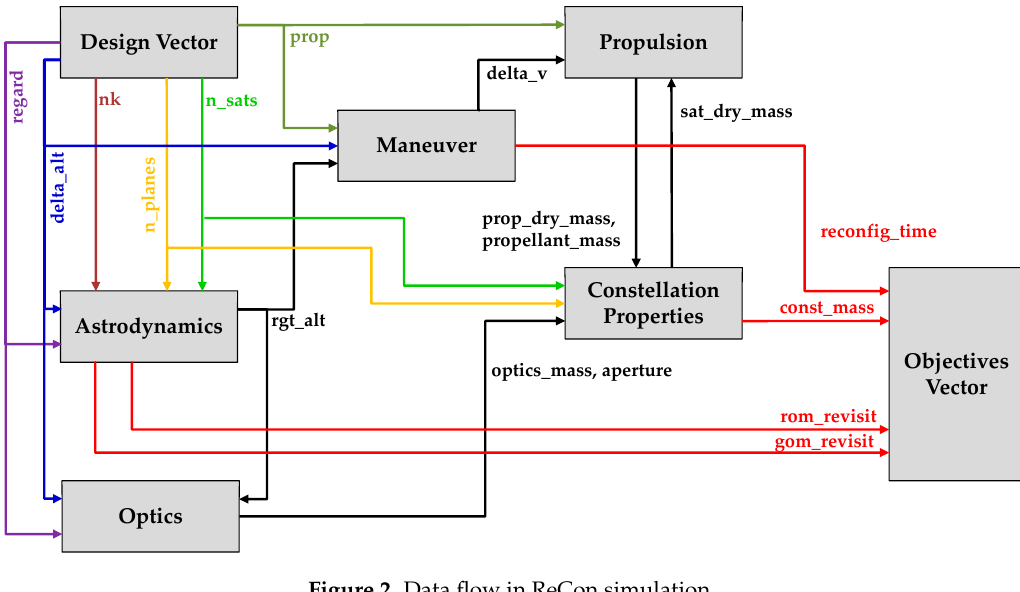
Figure 2. Data flow in ReCon simulation. Table 7. Inputs and output variables of simulation